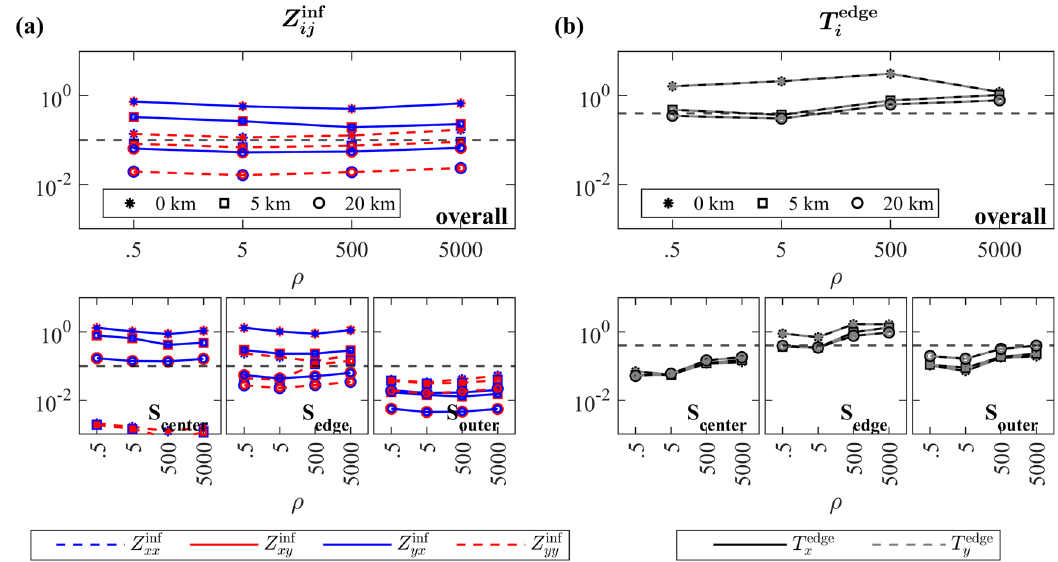
Fig. 2 a The impedance tensor influence indices Z inf xx , Z inf xy , Z inf yx and Z inf yy , and b the tipper edge effect indices T edge x and T edge y calculated with all stations according to (4) and (6), respectively, and just at the S center , S edge , and S outer stations, Eqs. (3) and (51), for the isotropic experiments where the resistivity of the 3‑D body is varied as shown on the x‑axis and buried at the surface, 5 km and 20 km. The dashed lines are at 0.1 for the impedance tensor and 0.50 for the tipper and mark the 10% and 50% levels,